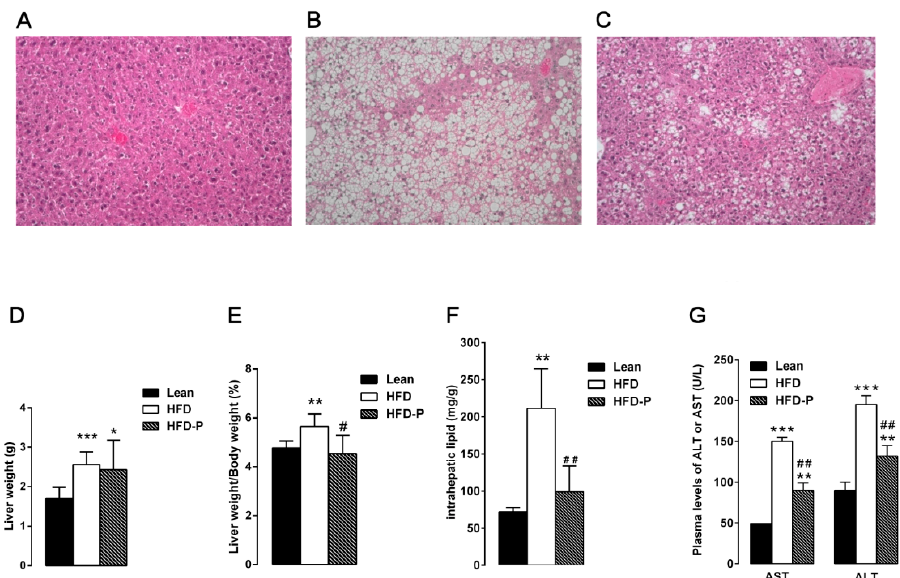
Figure 6. Pistachio consumption exerts positive effects on liver steatosis. Histological cross-sections of liver from lean ( A ), HFD ( B ), and HFD-P ( C ) mice belonging to reversal protocol. Hematoxylin and eosin stain. Original magnification: × 200. Liver weight ( D ), ratio of liver weight/body weight ( E ), intrahepatic lipid content ( F ), and plasma levels of AST and ALT ( G ) in lean, HFD, and HFD-P mice belonging to reversal protocol. Data are the means ± S.E.M. ( n = 8/group). Asterisk denotes significant difference compared with the lean group (* p < 0.05; ** p < 0.01; *** p < 0.001); hash denotes significant difference compared with the HFD group ( # p < 0.05; ## p < 0.01; ### p < 0.001). The analysis of adipose tissue volumes revealed a significant decrease of VAT and SAT in HFD- P mice in comparison with HFD mice. Moreover, adipocyte size, adipose tissue weight, and fat index were significantly reduced in HFD-P mice compared to HFD mice (Figures 7A–H).